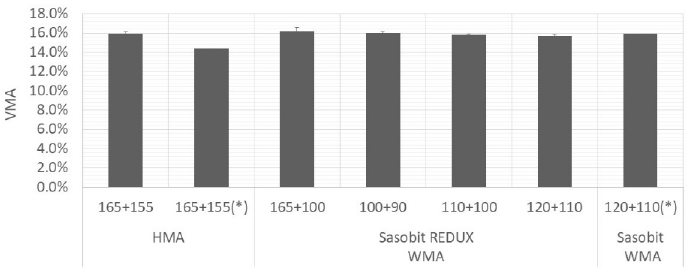
Figure 5. Variation of VMA with mixture and temperature.